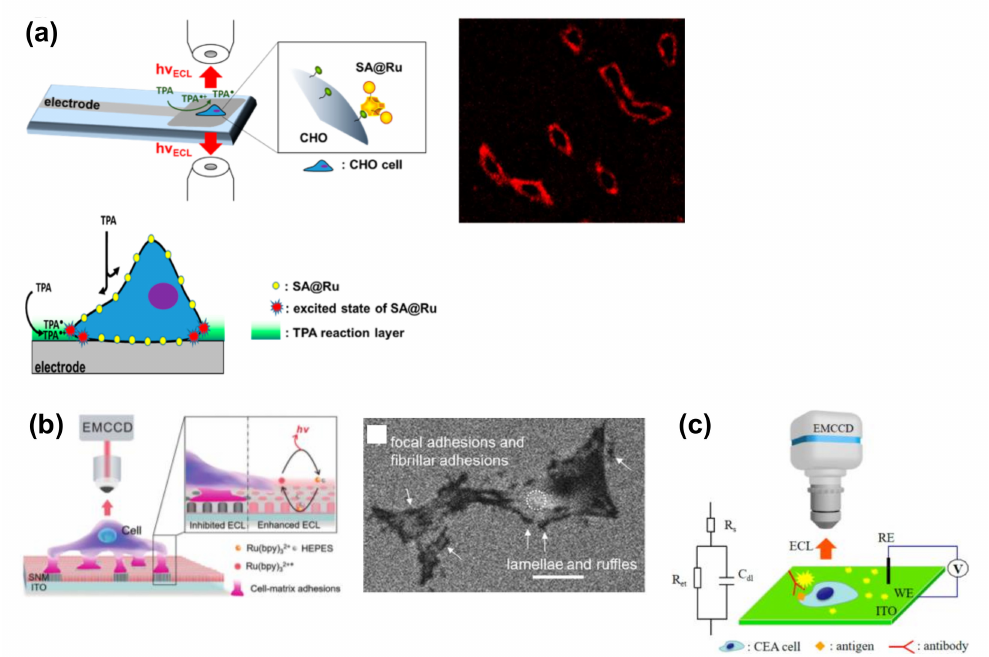
Figure 2. ECL imaging of cell membranes and cell adhesion. ( a ) ECL imaging of cell membranes. Chinese hamster ovary (CHO) cells were modified with biotin, and streptavidin-modified Ru(bpy) 32 + (SA@Ru) was then attached to the membranes. Reproduced with permission from [40]. ( b ) ECL imaging of cell-matrix adhesions. PC12 cells were cultured on the electrode. Scale bar = 20 µ m. Reproduced with permission from [21]. ( c ) ECL-based capacitance microscopy for the imaging of antigens on cells. Carcinoembryonic antigen (CEA) was labeled with an anti-CEA antibody. Reproduced with